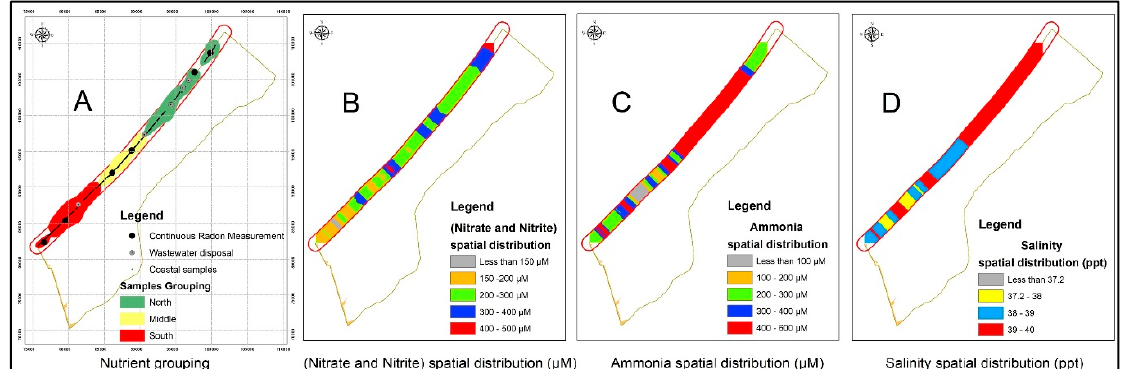
Figure 2. Nutrient sampling location and grouping, spatial distribution for NO 3 − + NO 2 − , NH 4 + , and salinity (map grid according to the Palestinian Grid System 1923). ( A ) Samples grouping vs wastewater disposal location; ( B ) Spatial distribution of NO 3 − + NO 2 − along the coastline; ( C ) Spatial distribution of NH 4+ along the coastline; ( D ) Spatial distribution of salinity along the coastline.